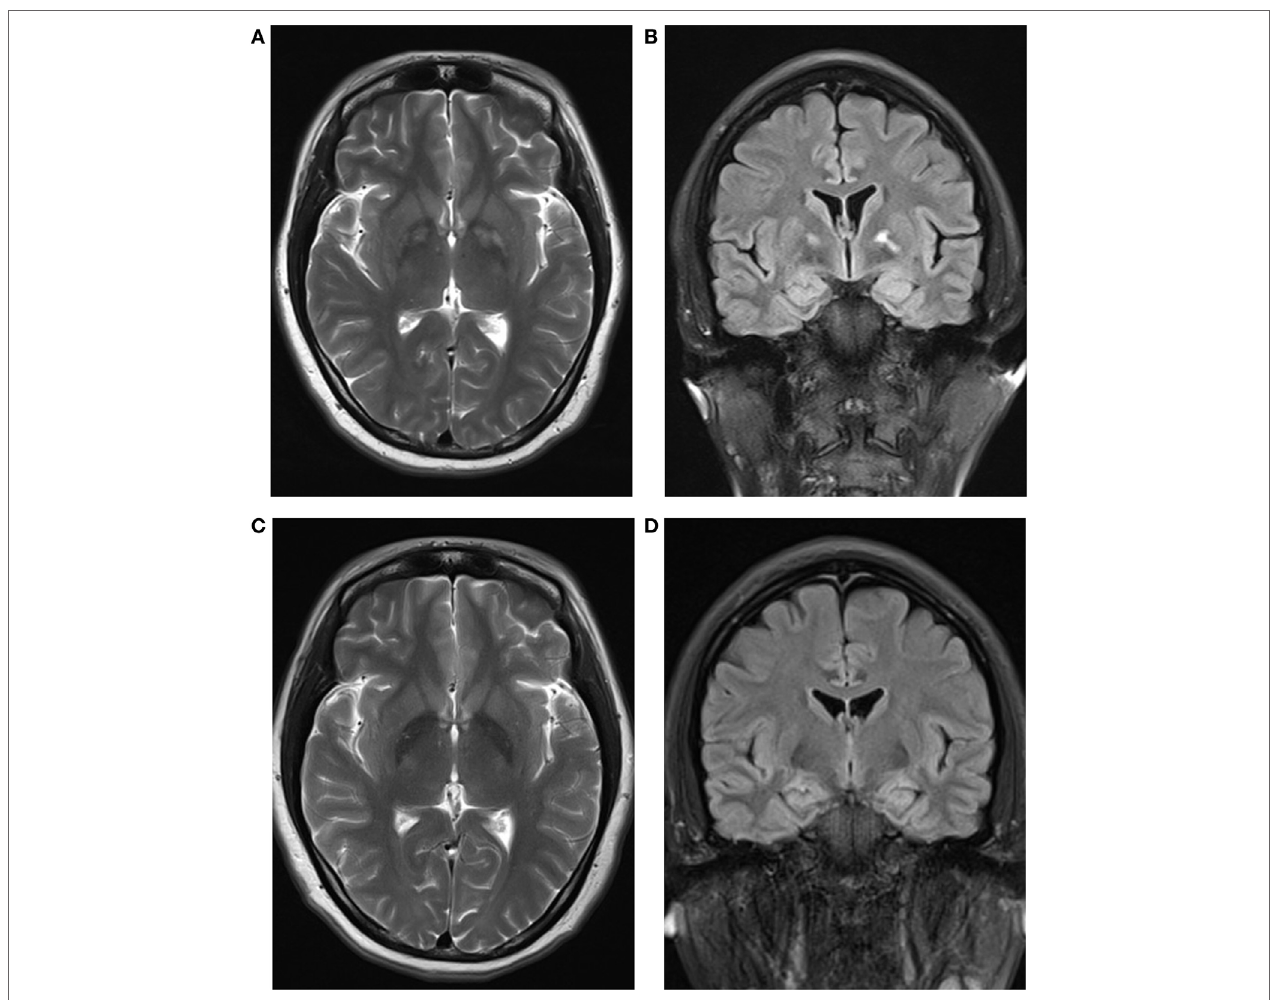
FiGURe 1 | (a,C) Axial T2-weighted magnetic resonance imaging (MRI) slices showing symmetrical hyperintensity in the globus pallidus at 17 days (a) and 3.5 months (C) after poisoning, demonstrating a reduction in globus pallidus hyperintensity. (B,D) Coronal fluid-attenuated inversion recovery MRI slices at 17 days (B) showing asymmetry of the hippocampus larger on the left side and improved symmetry at 3.5 months (D) after